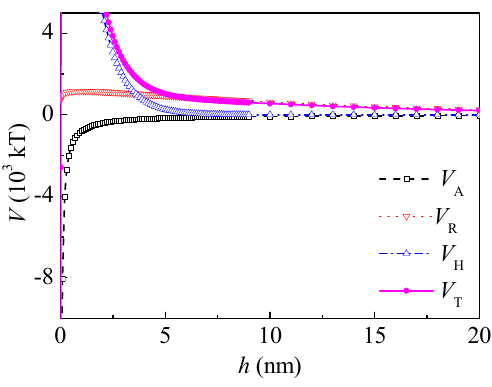
Figure 5. Potential energy between coal and kaolinite particles by extended Derjagin–Landau–Verwey–Overbeek (DLVO).